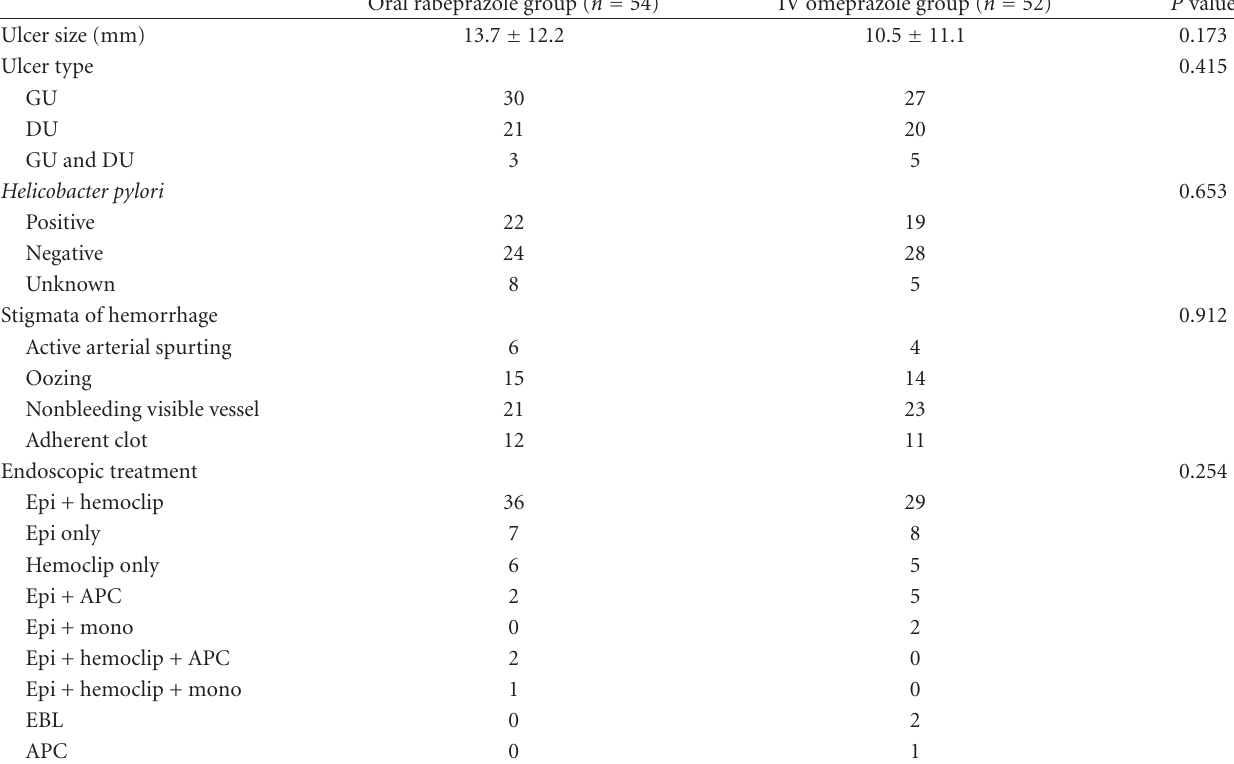
Table 2: Baseline characteristics (ITT population).